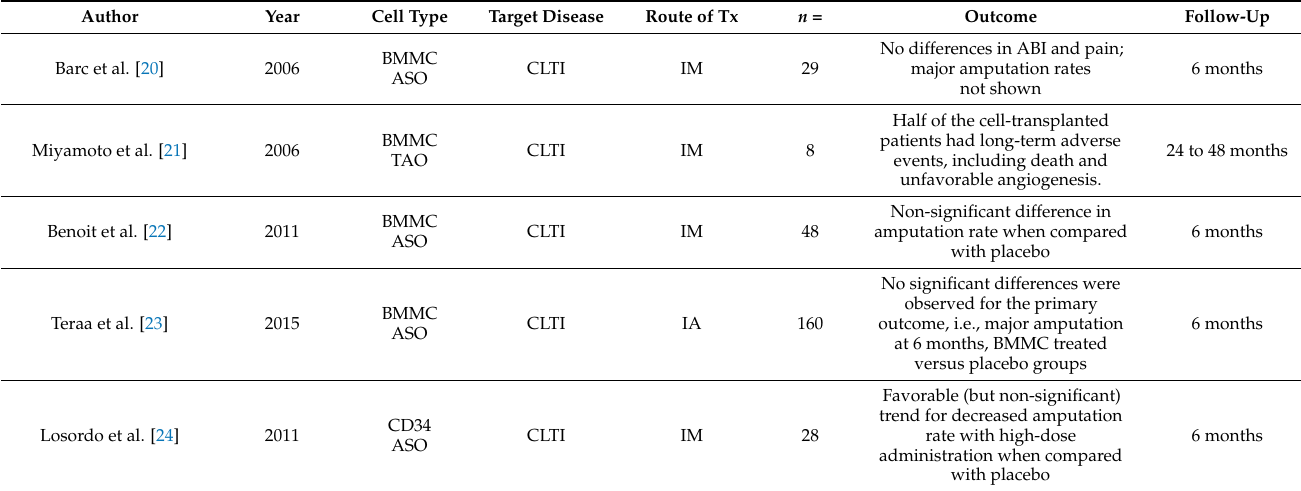
Table 2. Negative stem/cell-based trial outcomes in patients with